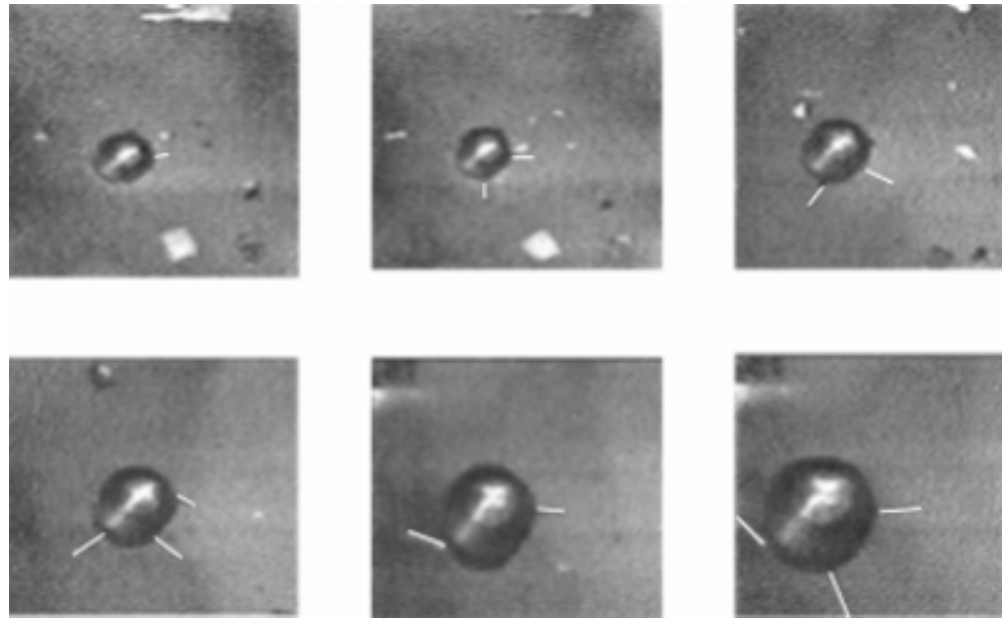
Fig. 10. Fin opening motion over a 36.5 m